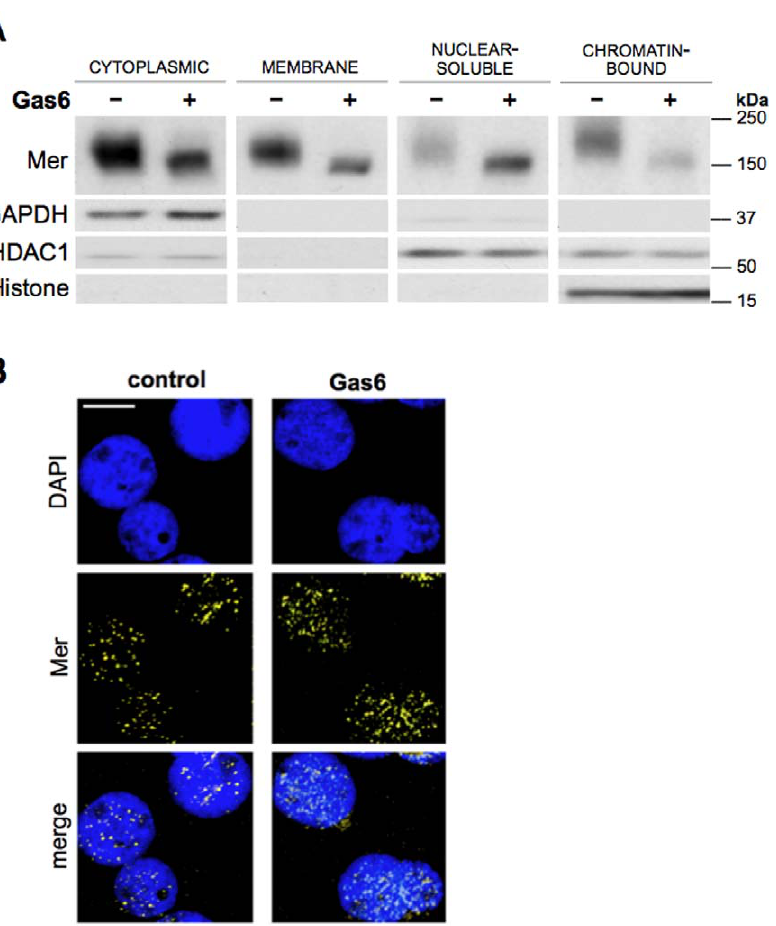
Figure 5. Prolonged Gas6 exposure alters Mer localization within the nuclear compartments. Jurkat cells were treated with 200 nM Gas6 ( + ) or vehicle control ( 2 ) for 24 hours. ( A ) Western blot detection of Mer following subcellular fractionation of cells. The following antibodies were used to assess compartment specificity: GAPDH (cytoplasmic), HDAC1 (both nuclear-soluble and chromatin-bound), and Histone H3 (chromatin- bound). ( B ) Following the 24-hour exposure, fixed and permeabilized cells were subjected to immunofluorescent staining and Mer expression ( yellow ) was analyzed by confocal microscopy. Nuclei were stained with DAPI ( blue ). Scale bar , 5 m m. doi:10.1371/journal.pone.0031635.g005 full-length RTKs in the nucleus [32], including members of the and insulin-like growth factor-1 receptor [38]. Expression of c-Met [39] and RON [40], receptors closely related to the TAM family fibroblast growth factor receptor [34–36], insulin receptor [37],